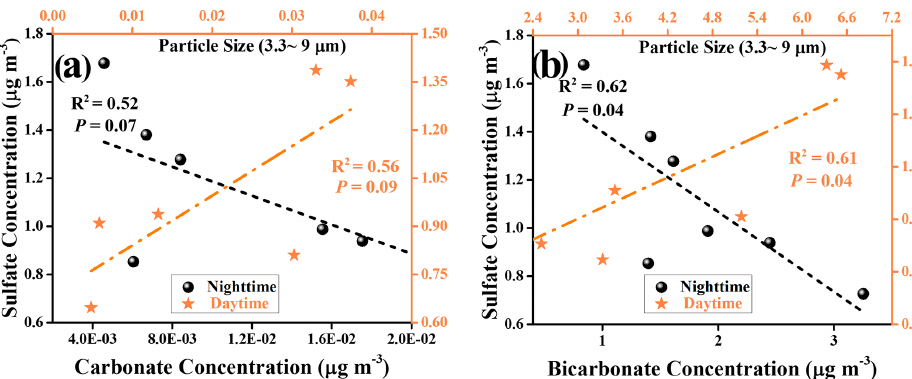
Figure 10. Field observation for the relationship between carbonate and sulfate ions during daytime and nighttime hours. Linear relationship analyses for measured sulfate ions and estimated carbonate ions (a) and for measured sulfate ions and estimated bicarbonate ions (b) during the daytime and nighttime hours, with particle sizes of PM ranging from 3.3 to